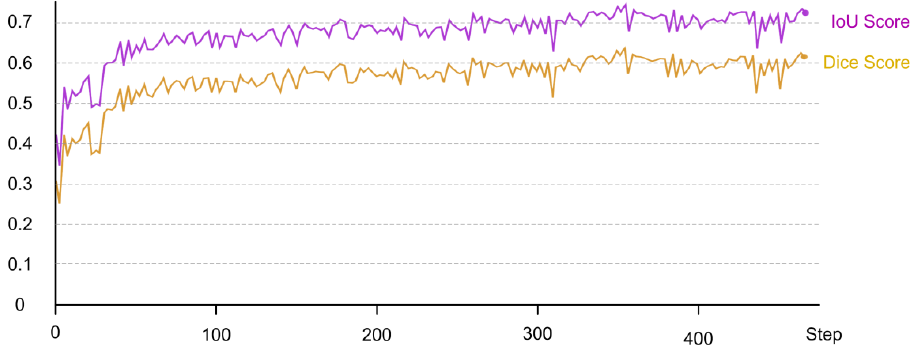
Figure 8. Performance metrics of U-Net image segmentation.